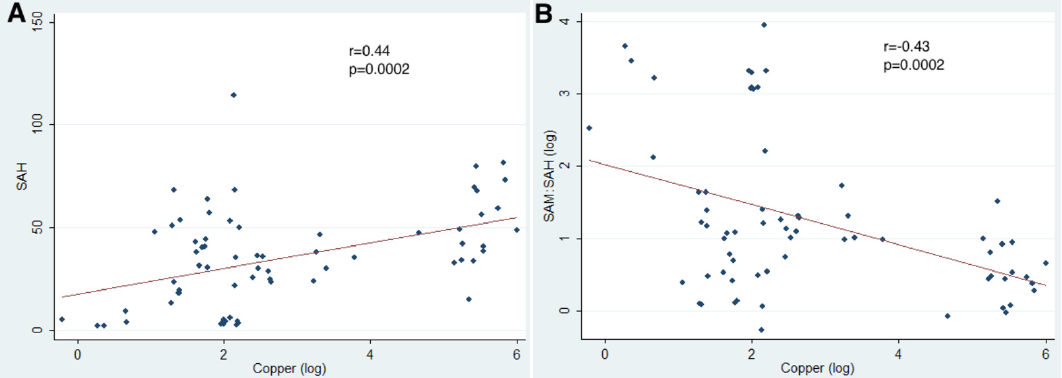
Figure 2. ( A ) Correlation between hepatic Cu concentration and SAH levels; ( B ) Correlation between hepatic Cu concentration and SAM:SAH levels (using data from all time points).